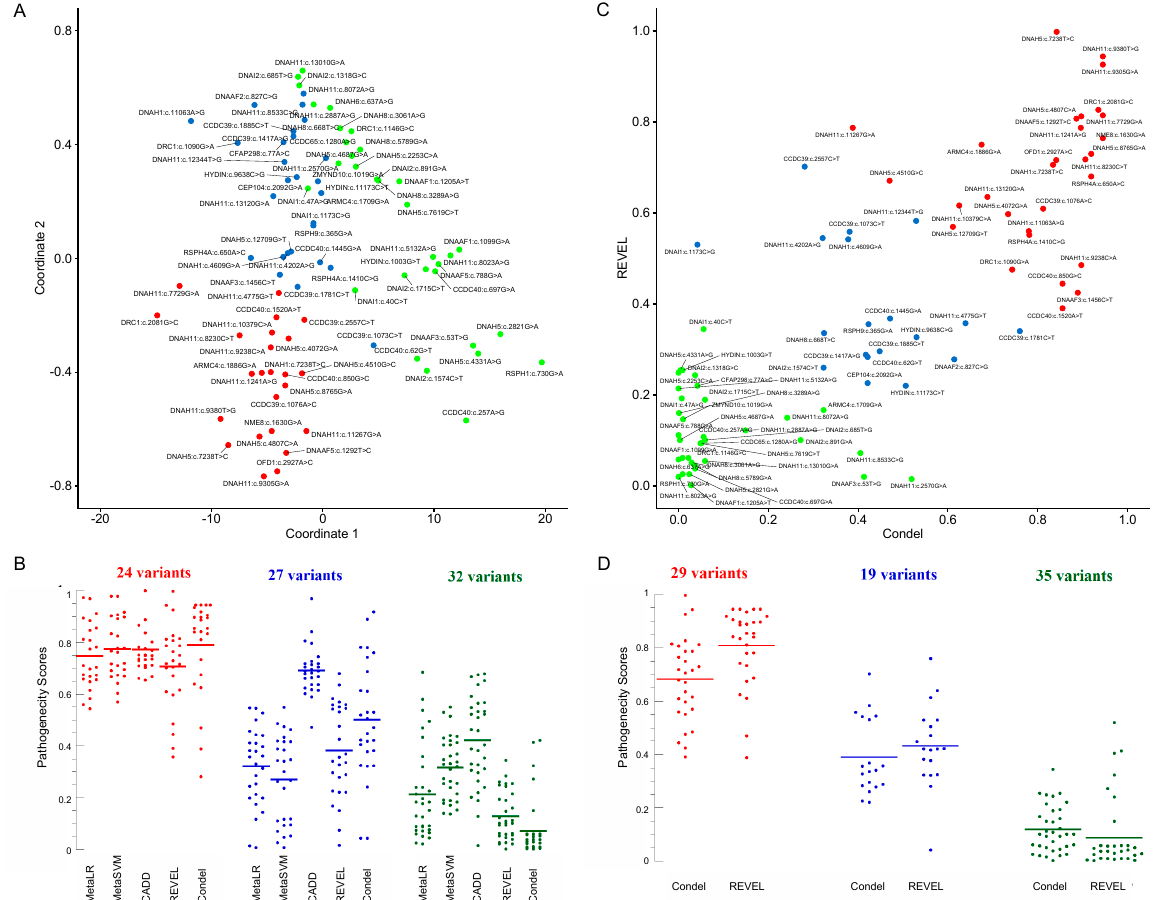
Figure 1. ( A ) Multidimensional scaling (MDS) plot of MetaLR, MetaSVM, CADD, REVEL, and Condel scores. Here, MDS reduces the dimensionality of the data and projects it on two abstract coordinates, which visualize the ‘closeness’ of points. The points were clustered into three groups using k-means clustering and colored red, blue, and green. The differences between the three groups (red, blue, and green) for each prediction scoring tool are significant ( p < 0.0001, Kruskal–Wallis H test). ( B ) A dot plot of the five pathogenicity predictor scores arranged according to the clusters identified in ( A ); the CADD scores were divided by 33 to aid data comparison. Horizontal lines are mean. ( C ) A scatter plot of REVEL versus Condel scores of the missense variants. The three k-means clusters obtained are colored in red (likely pathogenic), blue (uncertain), and green (likely benign). The difference between the clusters was significant ( p < 0.0001, Kruskal–Wallis H test). ( D ) A dot plot of the five pathogenicity predictor scores arranged according to the clusters identified in ( C ). Horizontal lines are mean.